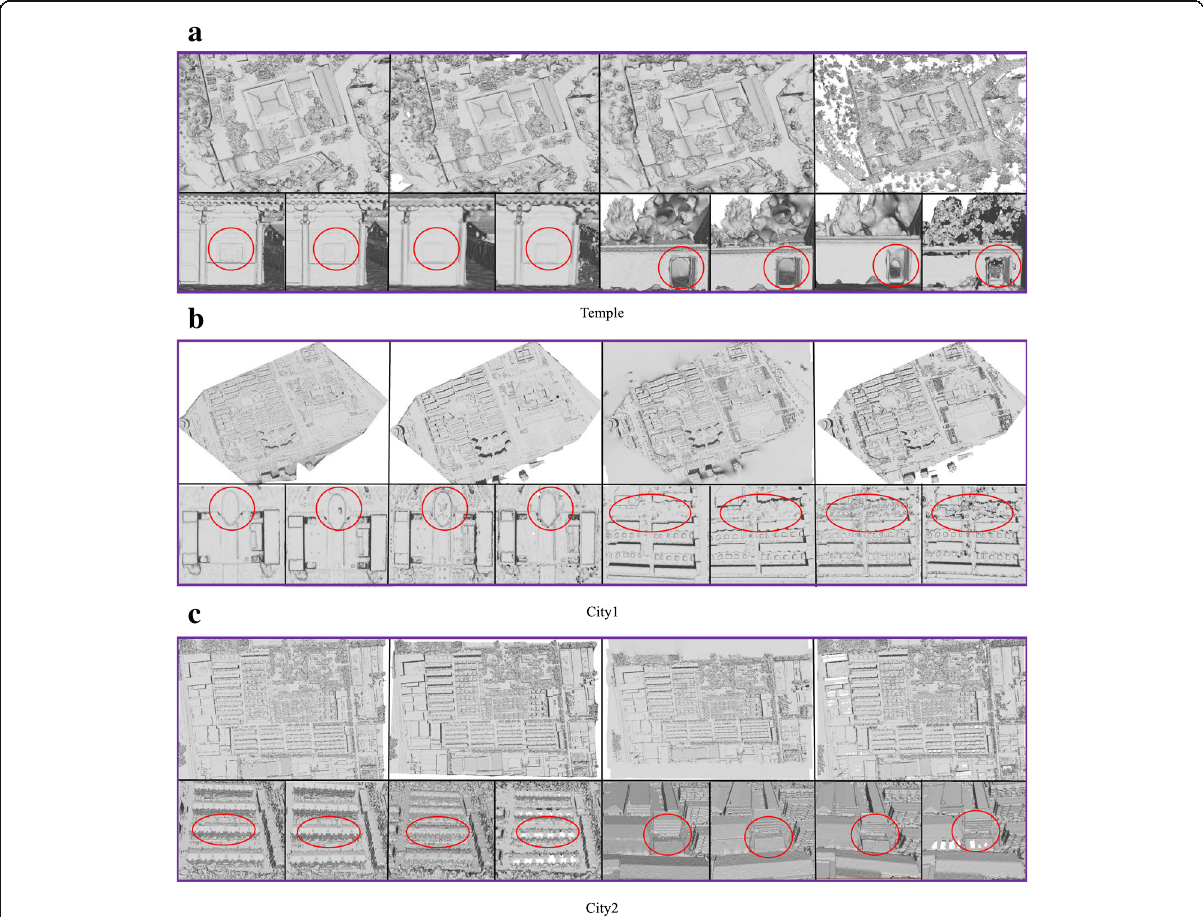
Fig. 6 Comparison of the different methods on the Temple, City1, and City2 datasets. In all [( a ), ( b ) and ( c )], the top row, from left to right, are the reconstruction results of our proposed method, Global, GDMR, and FSSR, respectively. The next row contains two details of the surface, and the columns in the two details represent the result of our method, Global, GDMR, and FSSR, respectively. The red circles highlight the surface quality of our approach, demonstrating that our proposed method and Global can obtain similar results. Both methods outperform GDMR